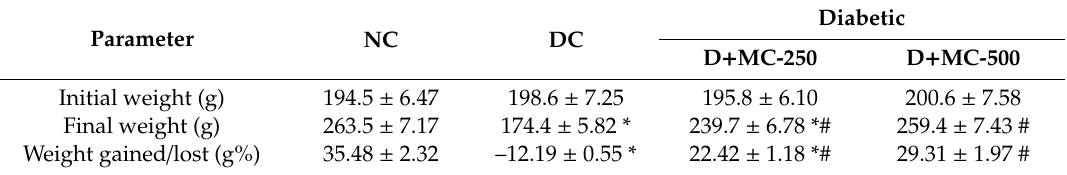
Table 5. E ff ect of MC on body weight of STZ-induced diabetic male rats. Table 5. Effect of MC on body weight of STZ-induced diabetic male rats. Parameter